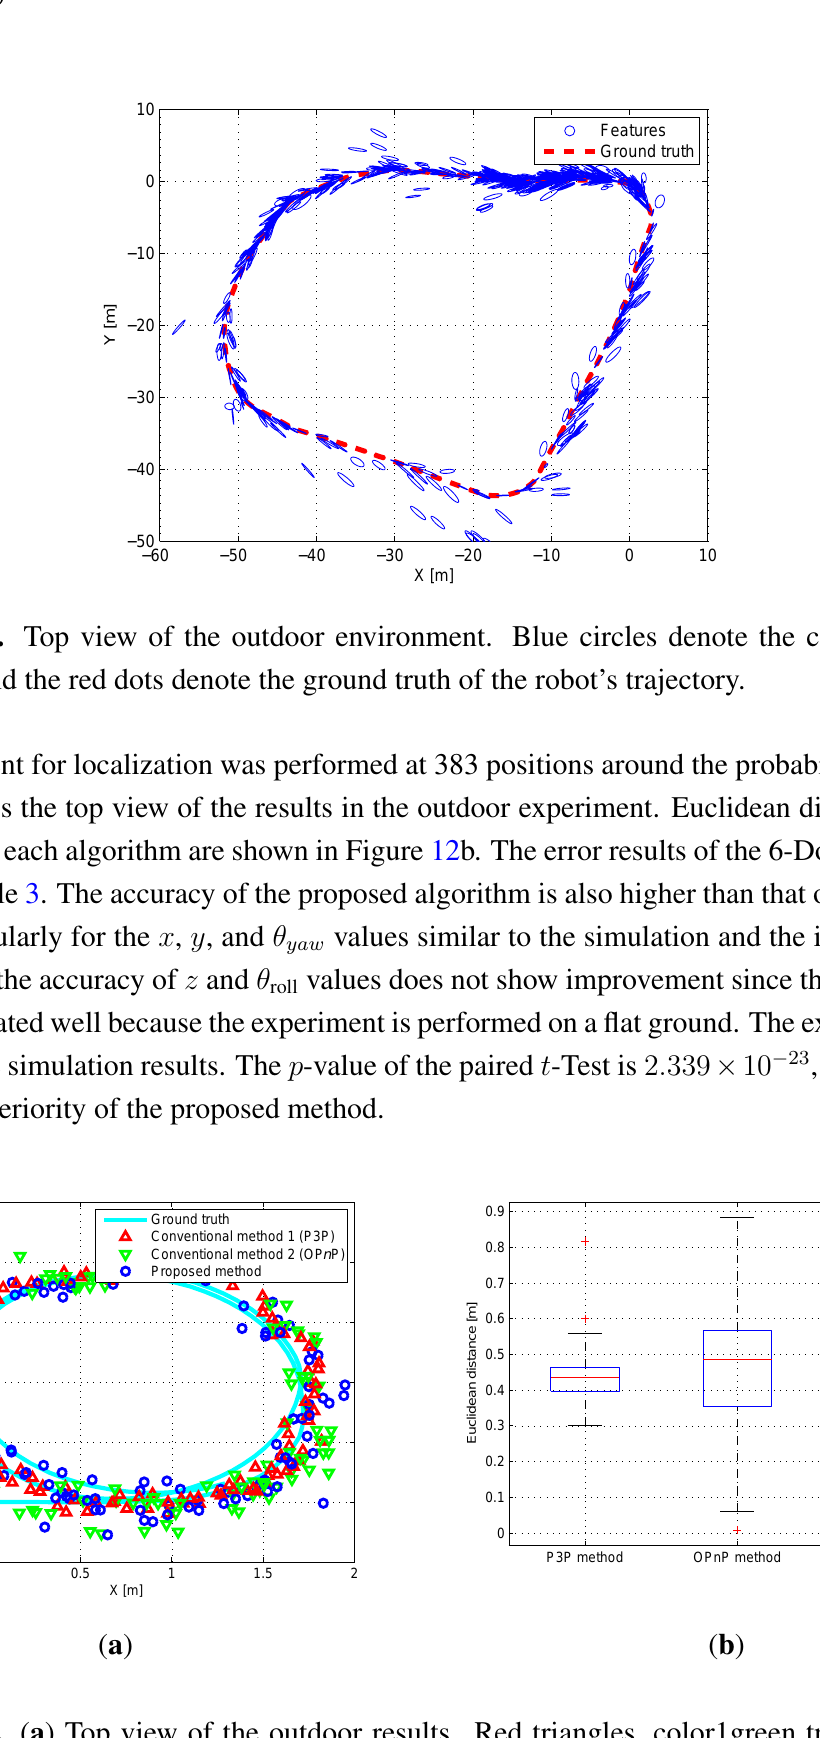
Figure 12. ( a ) Top view of the outdoor results. Red triangles, color1green triangles, and blue circles denote results of P n P, color1OP n P, and the proposed algorithm, respectively; ( b ) Euclidean distance errors relative to the reference